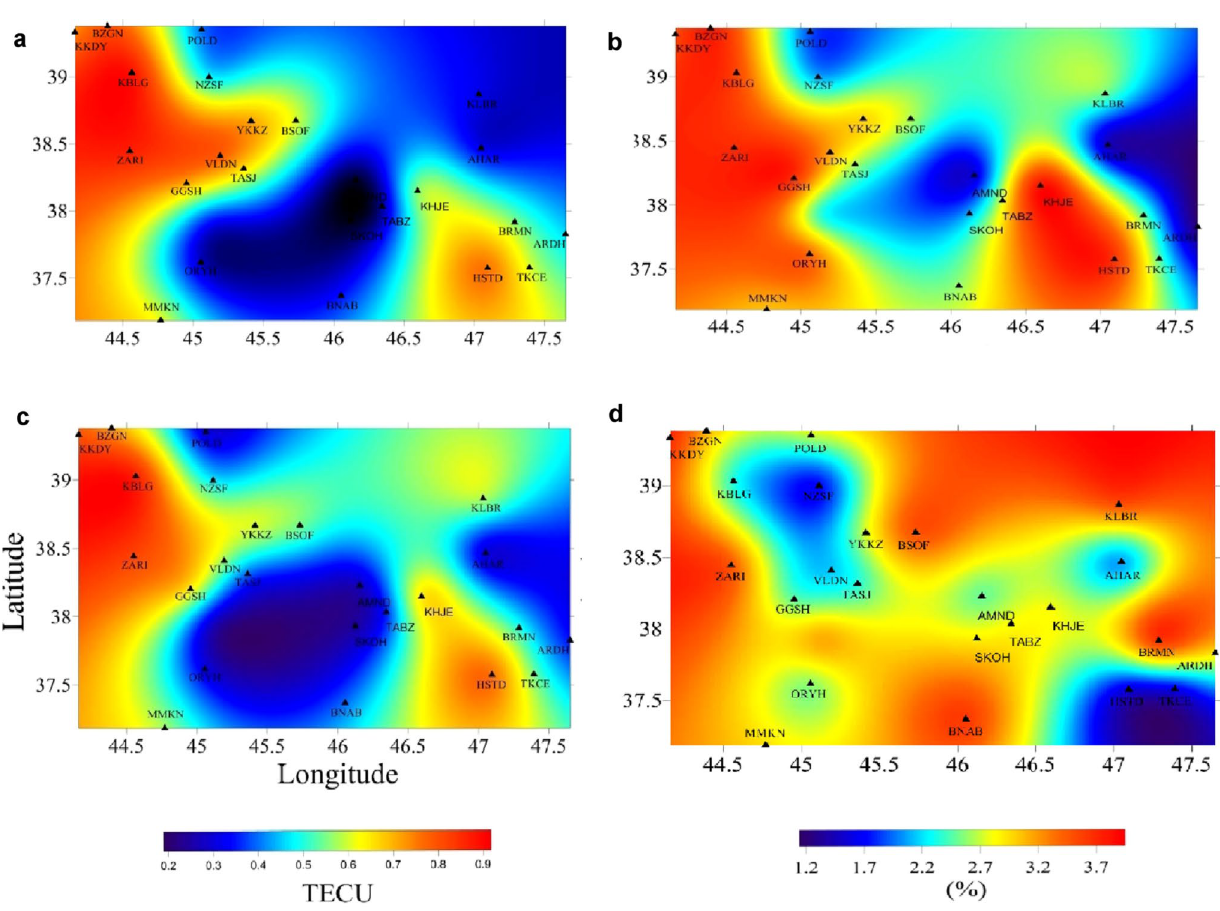
Fig. 4 a Absolute error during PLGSA b relative error during PLGSA c absolute error during PHGSA d relative error during